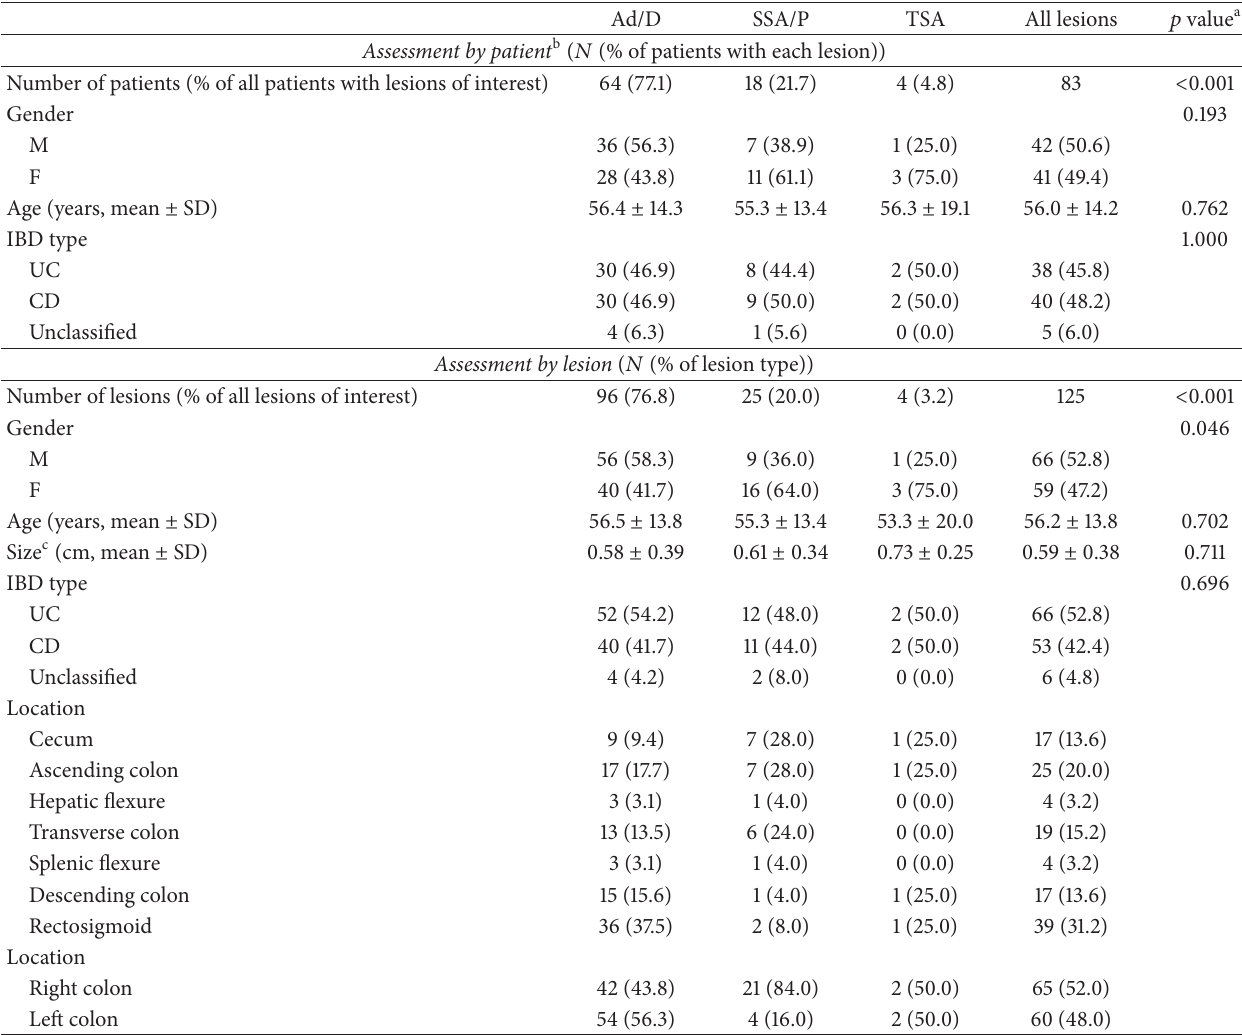
Table 1: Patient and premalignant lesion characteristics.